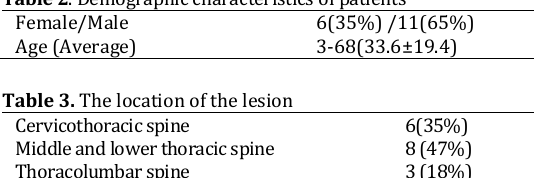
Table 2 . Demographic characteristics of patients Female/Male